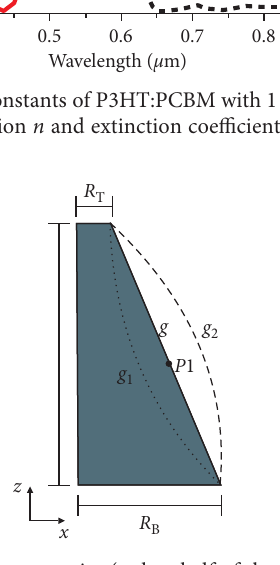
Figure 3: Side view geometries (only a half of the cross section is , and g shown) and generatrices g,g . For the convex truncated 1 2 . The generatrices are defined by the B´ezier curves with cone is g 2 the quadratic order